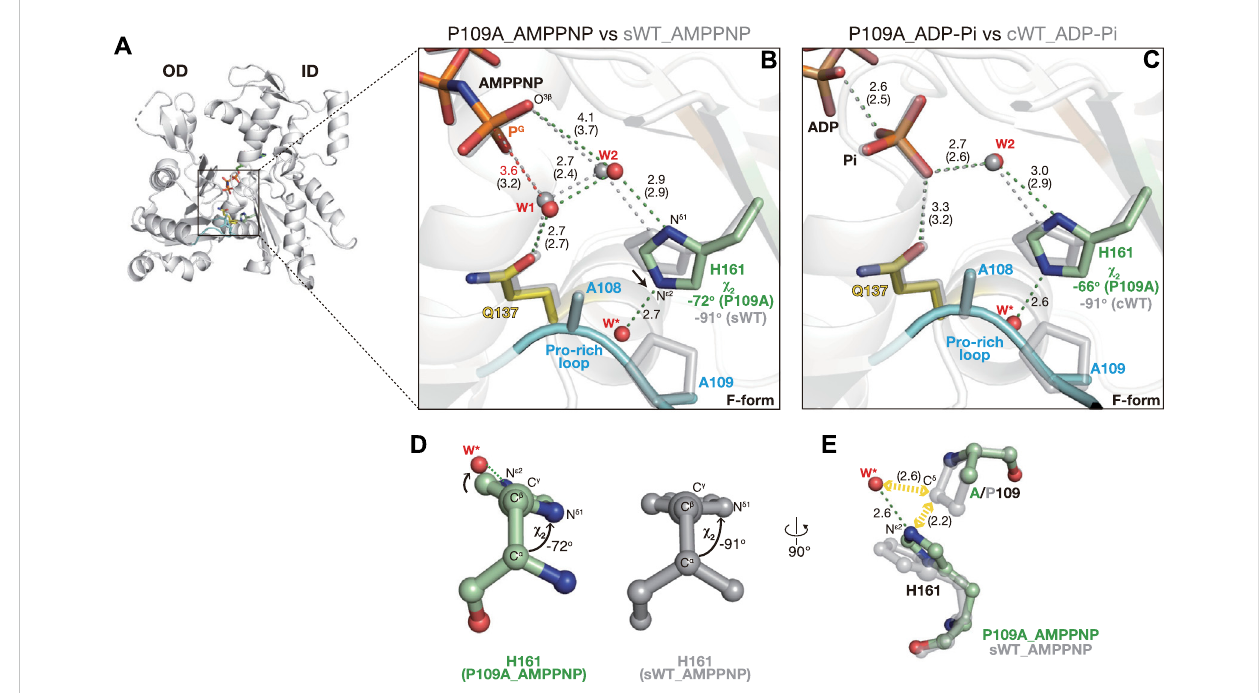
FIGURE 6 StructuresofP109A. (A) OverallstructureofP109A_AMPPNP(backview). (B – C) Close-upviewsoftheactivesiteofP109A_AMPPNP (B) andP109A_ ADP-P i (C) . For comparison, nucleotides, key residues, and water molecules from sWT_AMPPNP (B) or cWT_ADP-P i (C) are shown by transparent gray sticks/spheres. W* is a water molecule hydrogen bonded with the N ε 2 of His161 present only in the mutants. Distances (Å) between key atoms are indicatedwithcorrespondingdistancesinthereferencestructuresinparentheses. (D) χ 2 angleofHis161inP109A_AMPPNP(left)andsWT_AMPPNP (right). (E) Mechanism of His161 tilting. The loss of the proline ring allows (1) the approaching of His161 toward the Pro-rich loop, and (2) the entering of